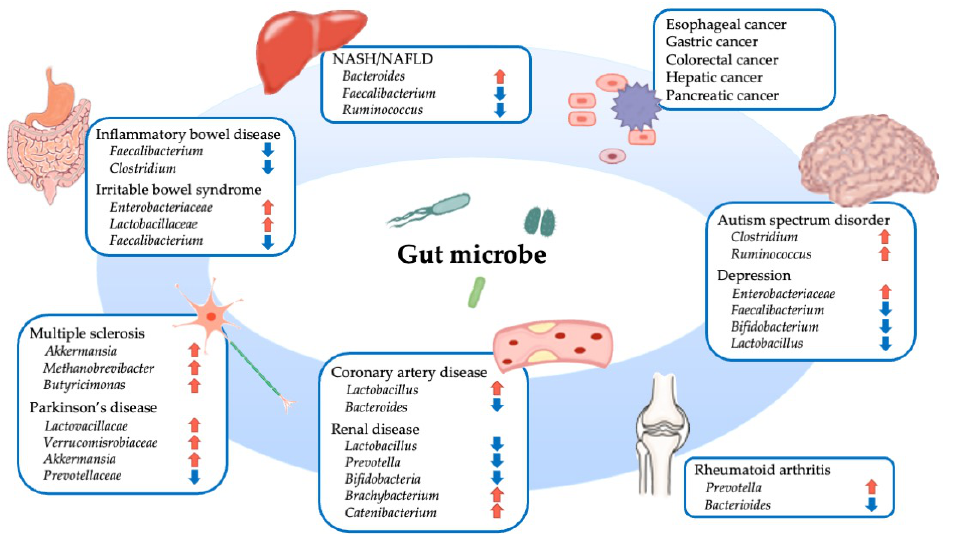
Figure 3. Overview of various diseases associated with gut microbes. NASH, nonalcoholic steatohepatitis; NAFLD, nonalcoholic fatty liver disease.